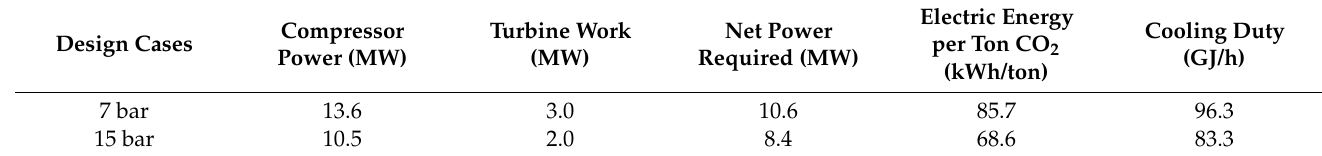
Figure 7. Process flow diagram for the open-cycle liquefaction design with a turbine and a valve. Table 5. Results of the open-cycle liquefaction design with a turbine and a